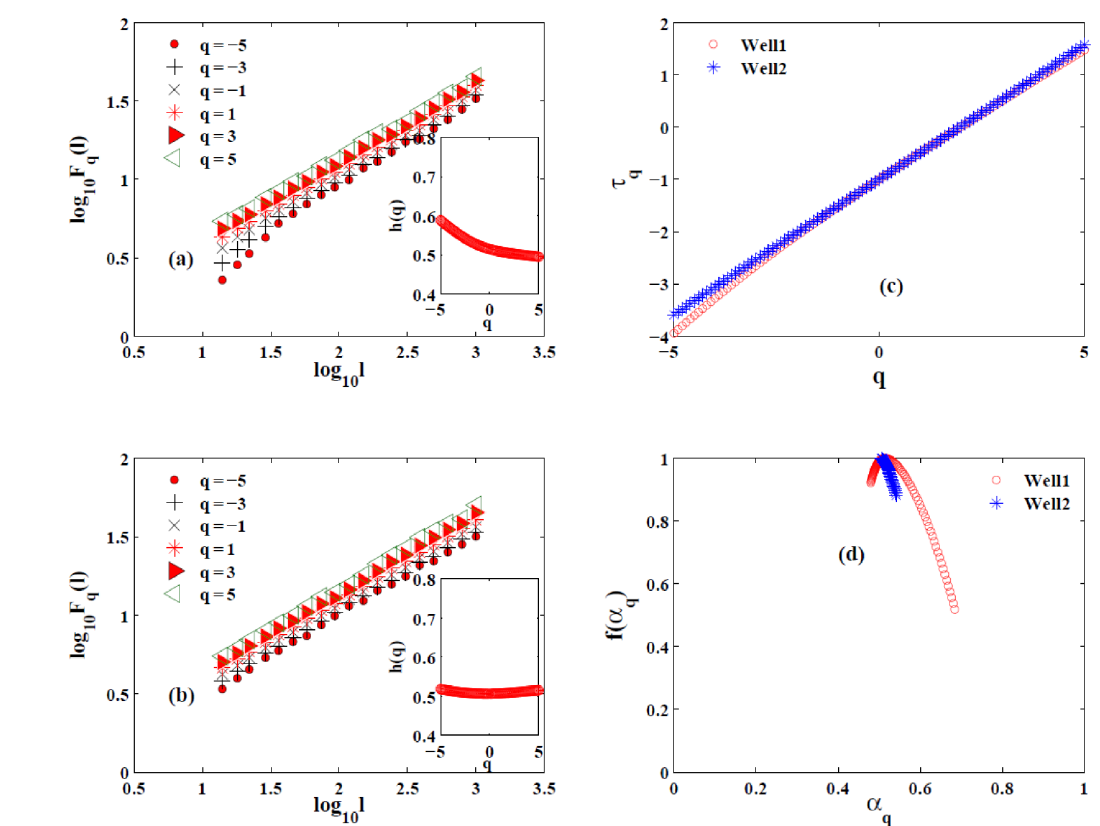
Figure 8. F q as a function of timescale l and the generalized Hurst exponent h as a function of q after shuffling for (a) Well 1 groundwater levels and (b) Well 2 groundwater levels. (c) The scaling exponent spectrum τ q vs. the moments for Well 1 and Well 2 groundwater levels after shuffling and (d) the singularity spectrum for Well 1 and Well 2 groundwater levels after